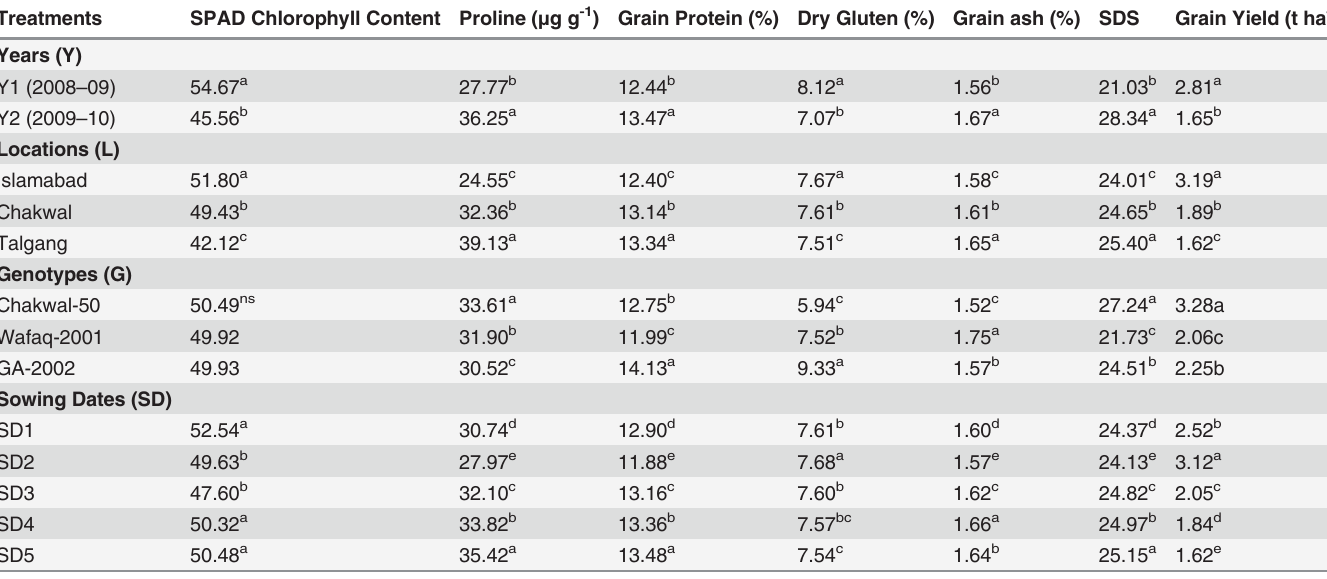
Notes: Means with similar letter(s) have no signi fi cant difference while different letters a,b,c,d,e showed that means are signi fi cantly different from each other at 0.05 probability levels, ns = non-signi fi